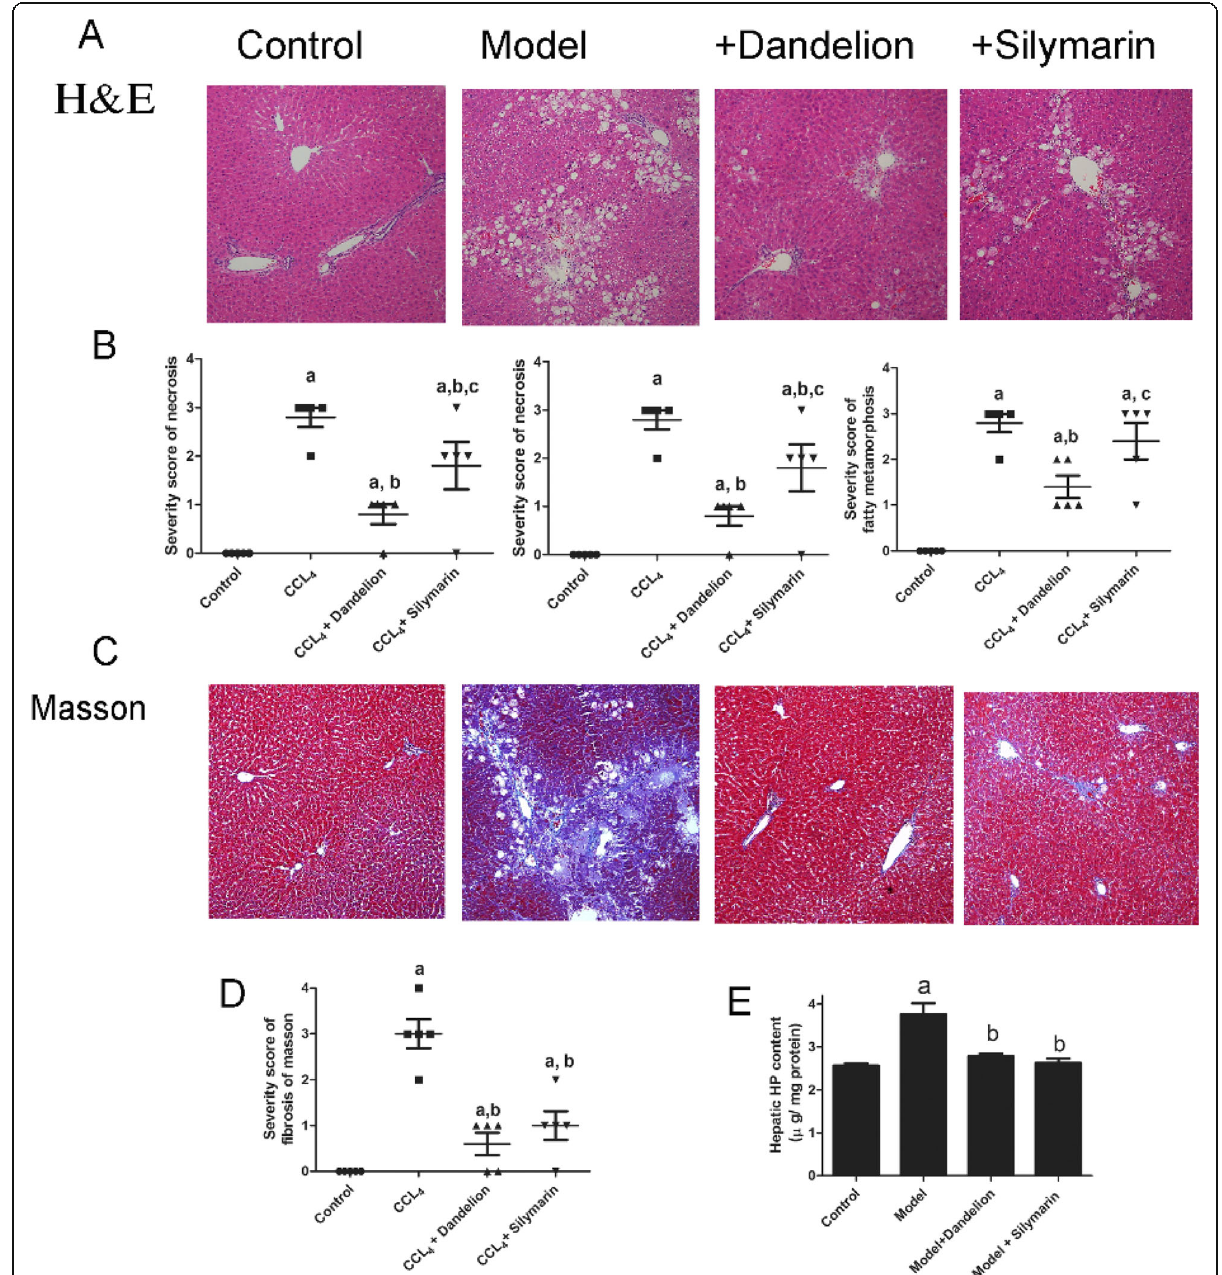
Fig. 3 Histological results of liver tissues of rats stained with H & E and Masson ’ s trichromic. ( a & b )The livers of rats treated with CCL4 showing degenerated and necrotic liver cells associated with inflammation and fatty change. Treatment with dandelion and silymarin reduced these pathological changes. All pictures are × 100 magnifications. ( c & d ) In Masson sections, collagens are stained blue. Liver sections of rats treated with CCL4 (model) and CCL4+ silymarin-treated rats showing massive fibrosis with sizable fibrous septa. The group treated with dandelion and silymarin showing less formation and accumulation of collagen fibrous. Magnification × 100. e Effect of dandelion and silymarin on hepatic HP content in CCL4-treated group (model). Each column represents the mean ± SEM for 5 rats per group. Units of HP content are μ g/mg protein. a P < 0.05 vs. control; b P < 0. 05 vs. CCL4 group; c P < 0. 05 vs. dandelion